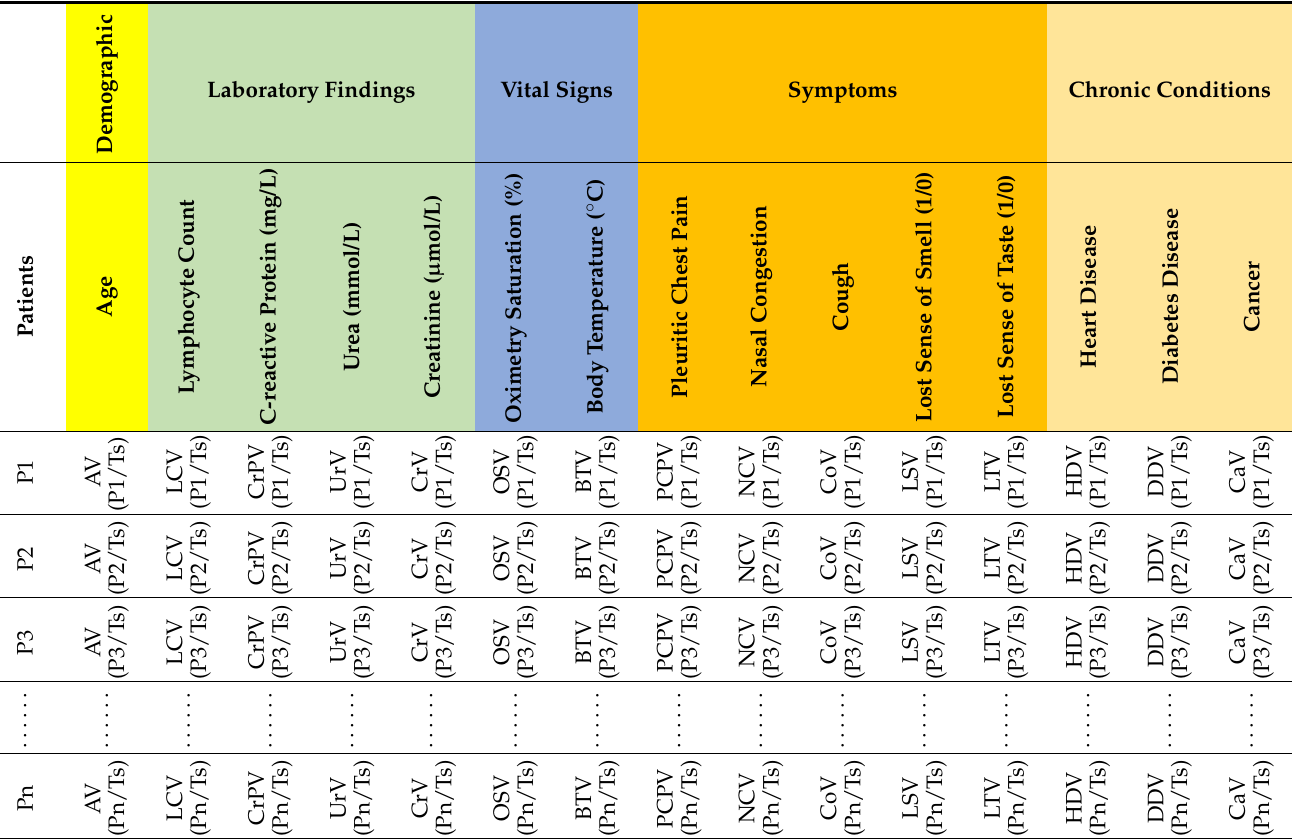
Table 2. Proposed Multidimensional Evaluation Matrix (MEM) for COVID-19